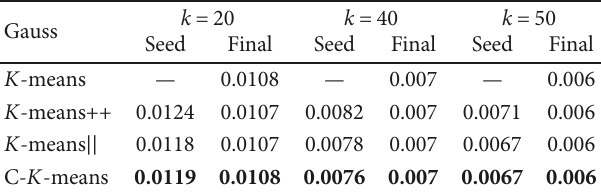
Table 9: Median cost (over 10 runs) on the Gauss dataset.